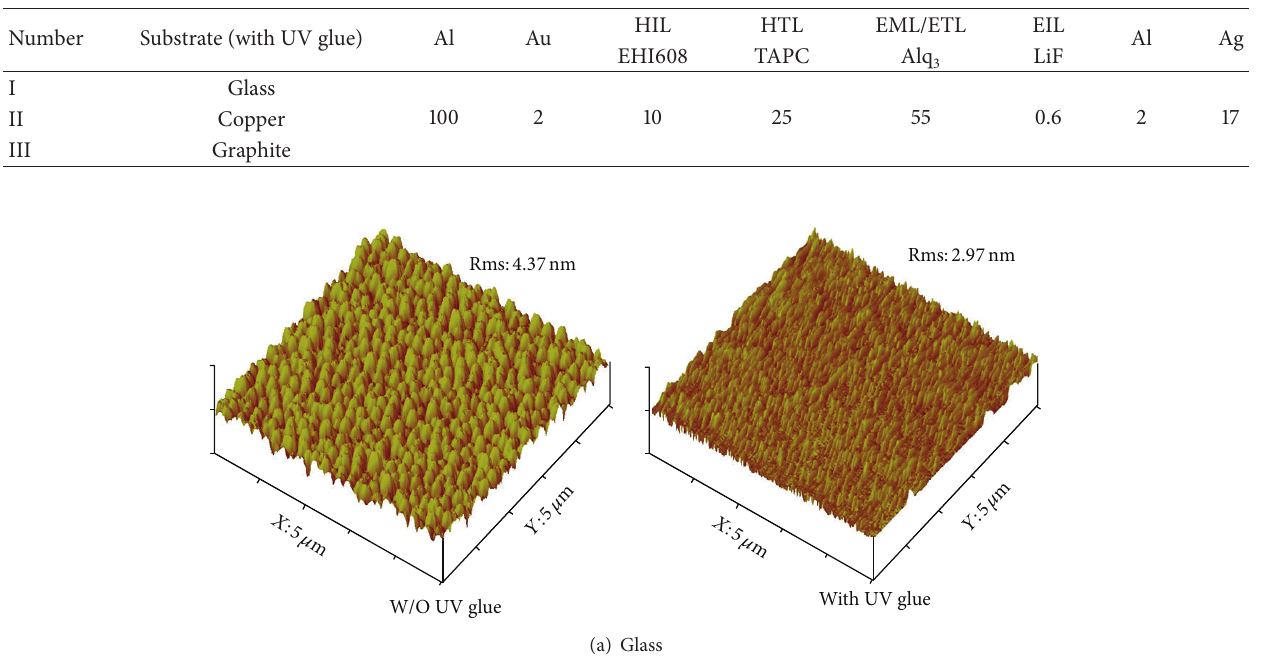
Table 2: Parameter of each layer for TEOLED (unit: nm).